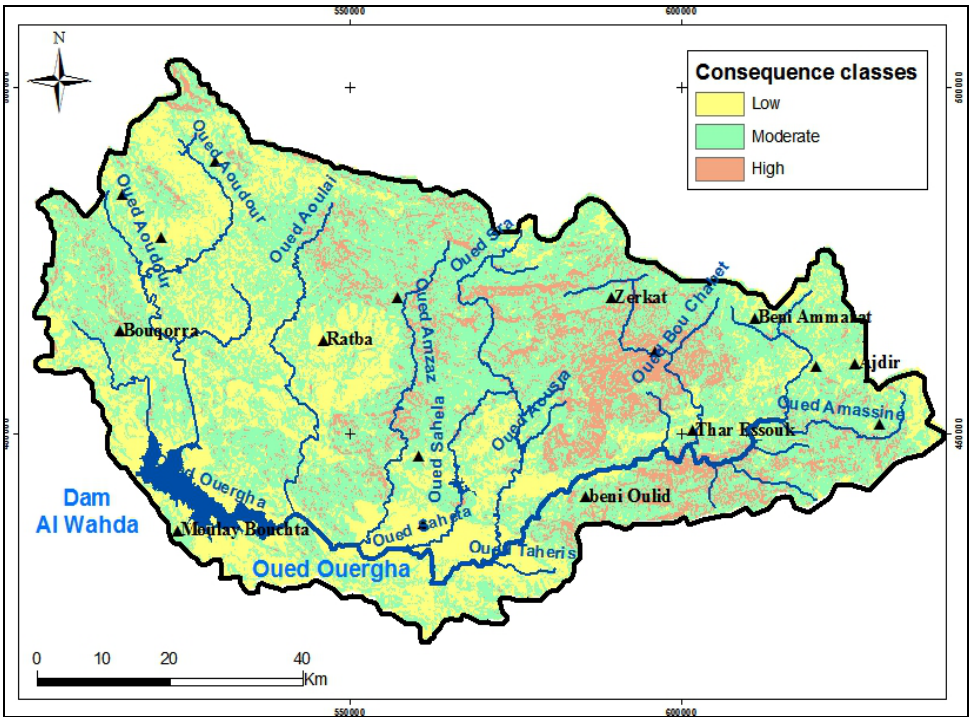
Figure 8 . Consequences and damage of the Ouergha watershed Results and discussion